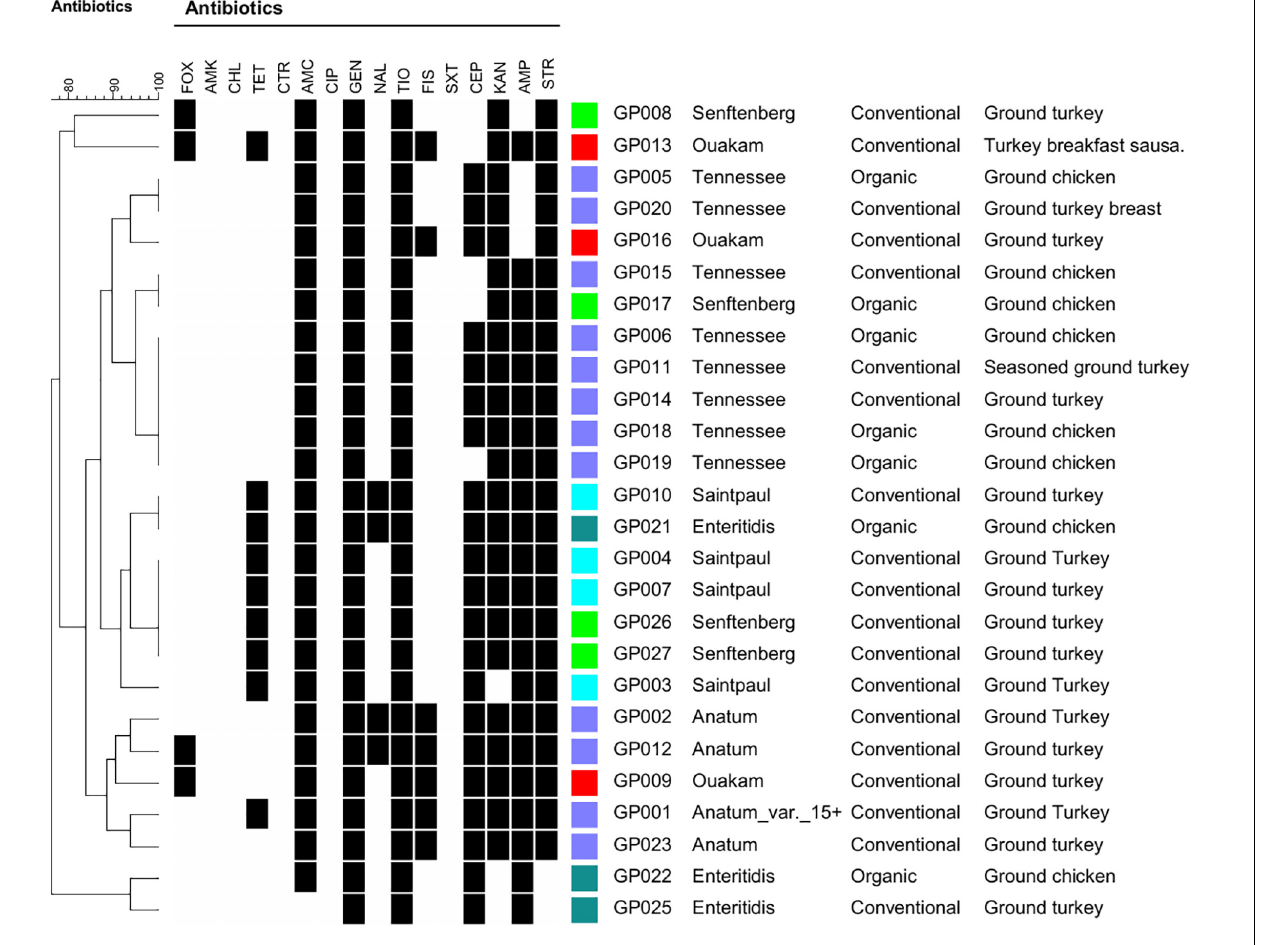
Frontiers in Microbiology |